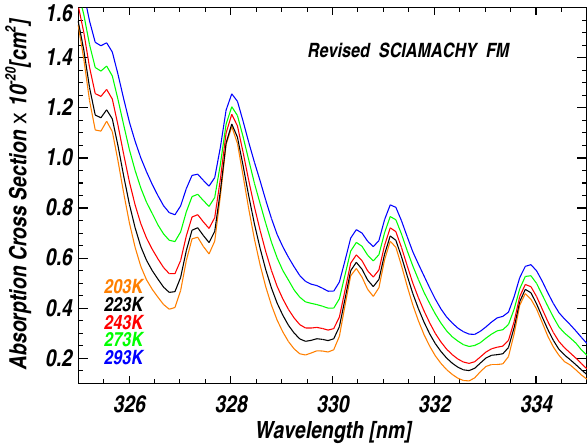
Fig. 3. Full spectra of ozone optical density (channel 2) obtained by concatenating the useful parts of each absorption measurement as indicated by different colours.